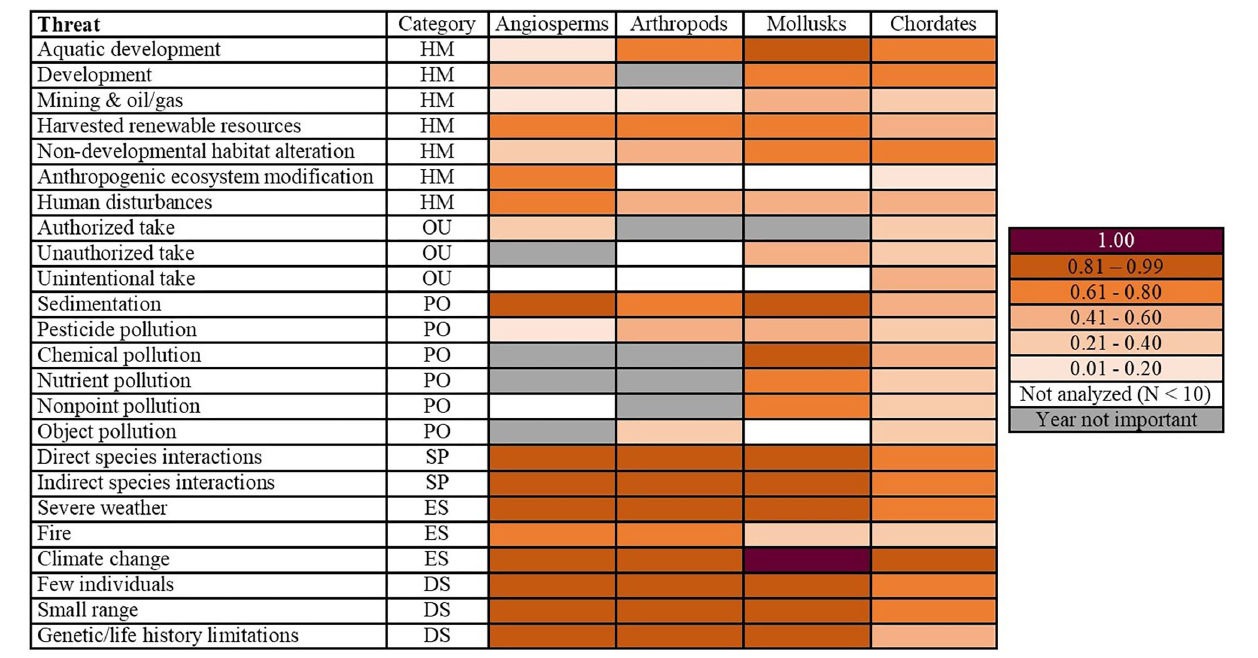
FIGURE 1 | Peak probabilities of being impacted by a threat. Mollusks had the greatest number of topmost threats (peaking at ≥ 0.81). Category corresponds to the broad-resolution threats of habitat modification (HM), overutilization (OU), pollution (PO), species interactions (SP), environmental stochasticity (ES), and demographic stochasticity (DS). Year not important denotes that there was no year effect for a particular threat/phyla combination (the null model was the best fit). Not analyzed ( N < 10) is noted for phyla for which a given threat was not analyzed due to insufficient sample size. The 1.00 probability indicates we were unable to model the data because of perfect